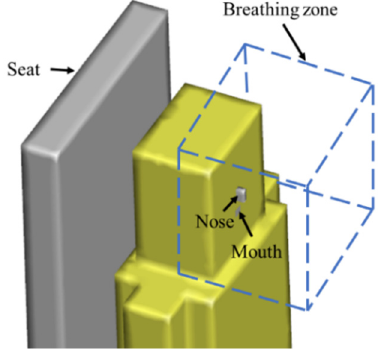
Figure 3. Breathing area of Passenger.